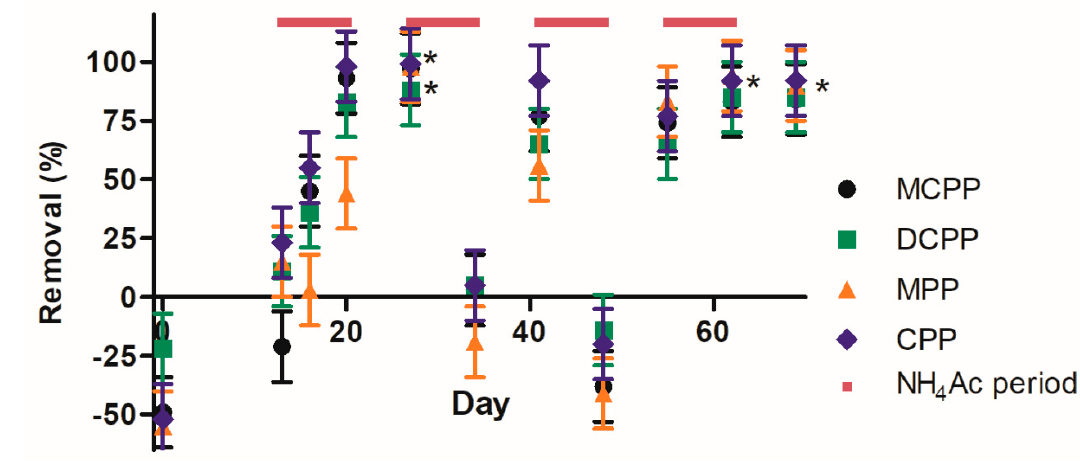
Figure 2. Sand biofilter: Removal rate (%) of CPP ( ♦ ), DCPP ( ■ ), MCPP ( ● ), and MPP ( ▲ )during the experimental period. Orange bars indicate the periods in which NH 4 Ac was applied. Error bars were set to ± 15% by calculation from calibration functions, and asterisks (*) indicate where outlet values were below